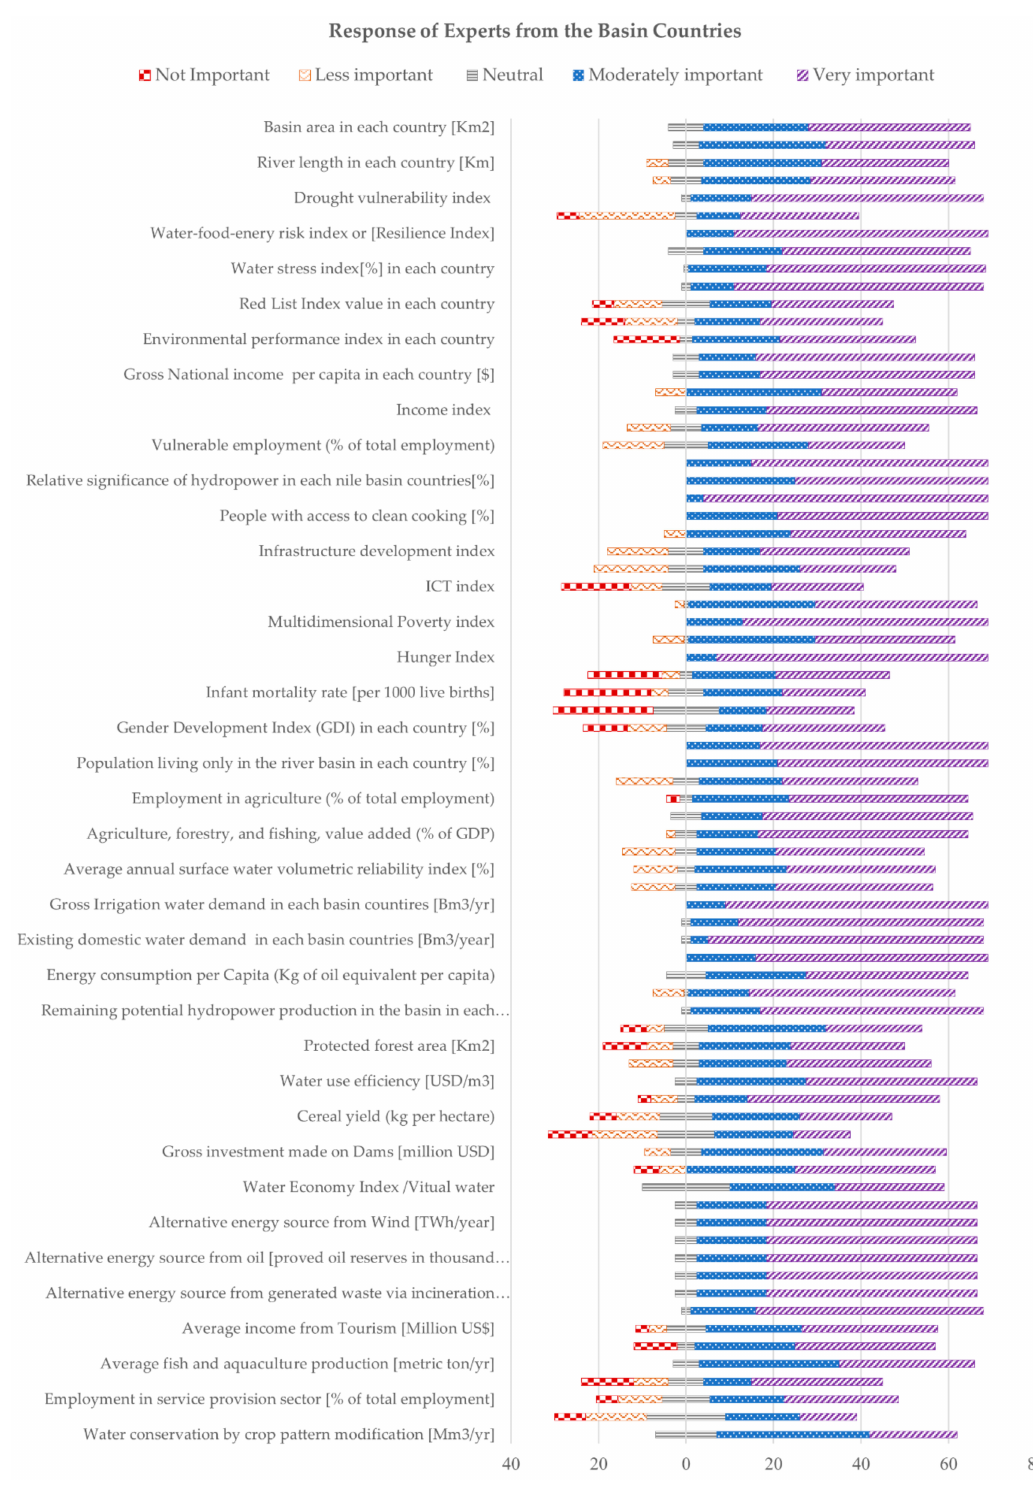
Figure 5. A percentage summary of survey responses for indicators from basin state